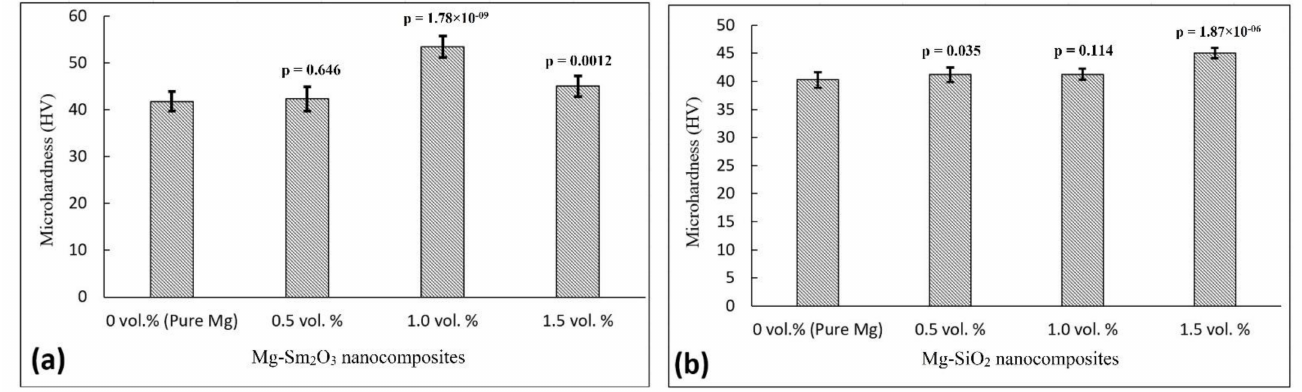
Figure 3. Microhardness measurements of the prepared nanocomposites. ( a ) Mg-Sm 2 O 3 nanocom- posite with maximum microhardness achieved at 1 Vol% ( p = 1.78 × 10 − 09 , n = 13, compared to pure Mg), and ( b ) Mg-SiO 2 nanocomposite with maximum microhardness achieved at 1.5 Vol% ( p = 1.87 × 10 − 06 , n = 10, compared to pure